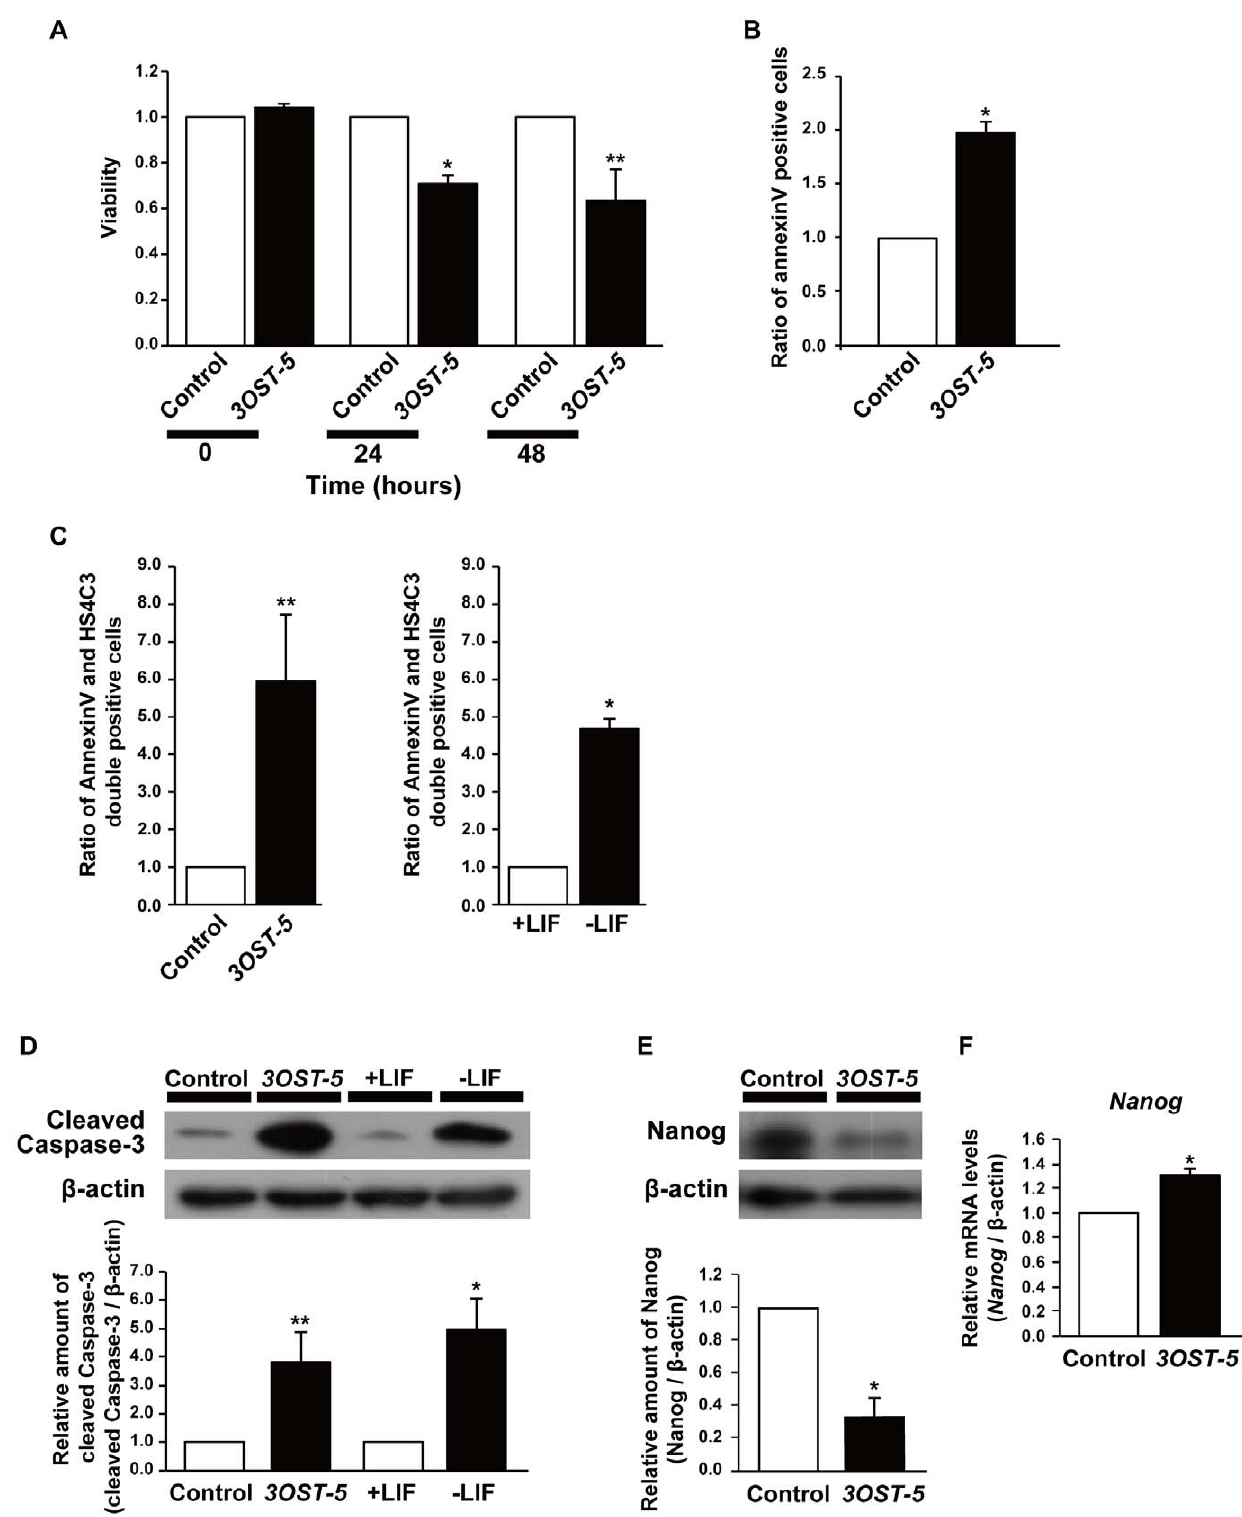
Figure 2. Activation of caspase-3 and degradation of Nanog are induced in cells overexpressing 3OST-5 . (A) Viability of cells overexpressing 3OST-5 . Viability was measured as described in Materials and Methods. The values shown are the means 6 SD of triplicate measurements from one representative experiment after normalization against control cells (arbitrary value=1). (B) Measurement of the rate of apoptosis in mESCs using an annexin V-FITC kit at 2 days after transfection with the 3OST-5 expression construct. The values shown are the means 6 SD after normalization against control cells (arbitrary value=1). (C) FACS analysis, using the HS4C3 antibody and annexin V, of mESCs at 2 days after transfection with the 3OST-5 expression construct ( left graph ) or of mESCs cultured for 8 days in the absence of LIF ( 2 LIF) ( right graph ). The